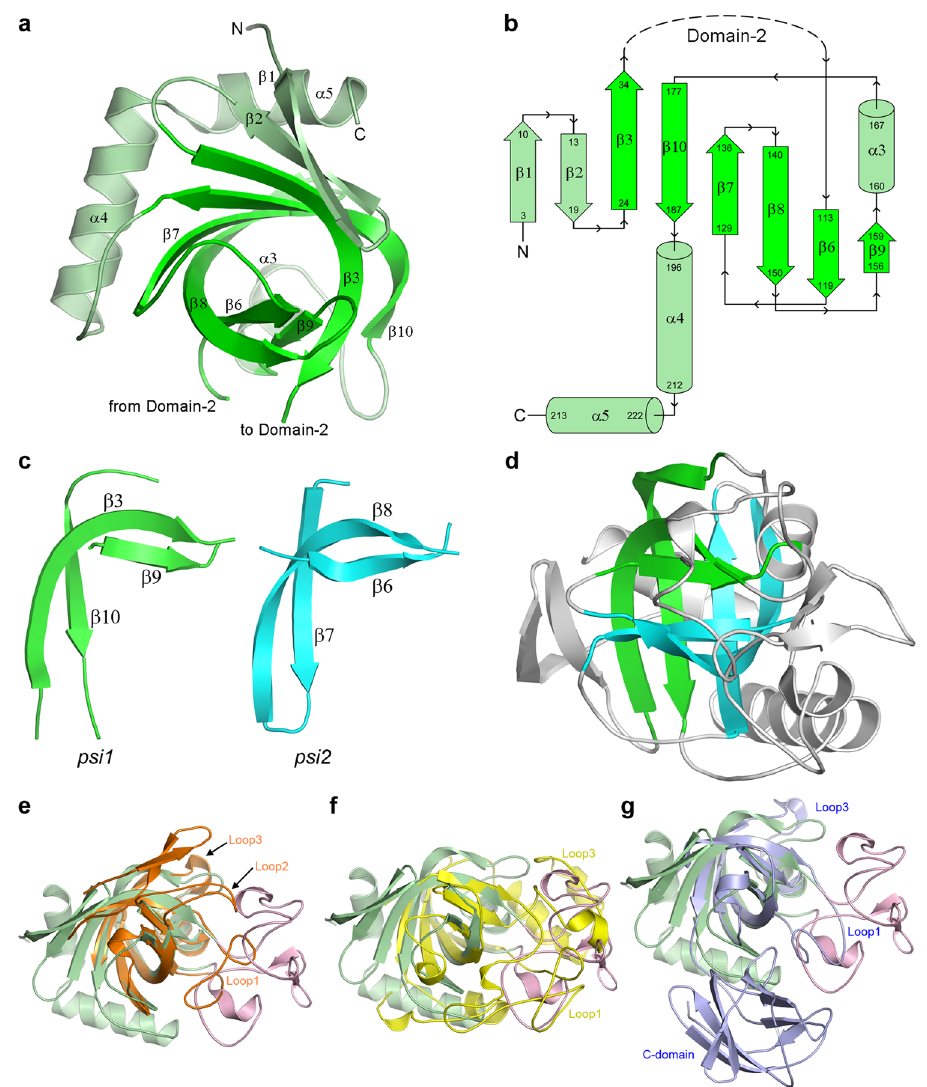
Fig.3|Domain-1structureandtheDPBBmotif.a Domain-1oftheapo1structure orientedto look down the double- psi β -barrel(DPBB) structural motif.The strands making up the DPBB are highlighted in bright green. b Topology diagram of Domain-1 highlighting the fold of the DPBB motif (bright green). c The two psi motifs(greenandcyan)fromtheV-Csnapo1structure,showninapproximatelythe sameorientationsothattheirstructuralsimilarityisevident. d Thetwo psi motifsin thecontextoftheV-Csnapo1structure.Thegreen psi motifisinapproximatelythe same orientation as in c and the cyan psi motif is rotated about 180° about an axis into the page. Together they make up the double- psi β -barrel (DPBB) structural motif. e Superposition of V-Csn Domain-1 (light green) and kiwellin from Actinidia